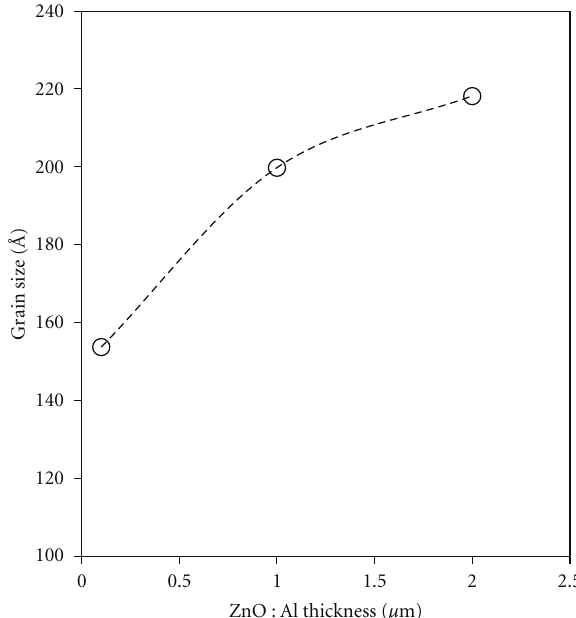
Figure 2: Calculated grain size for the ZnO:Al films grown from ceramic